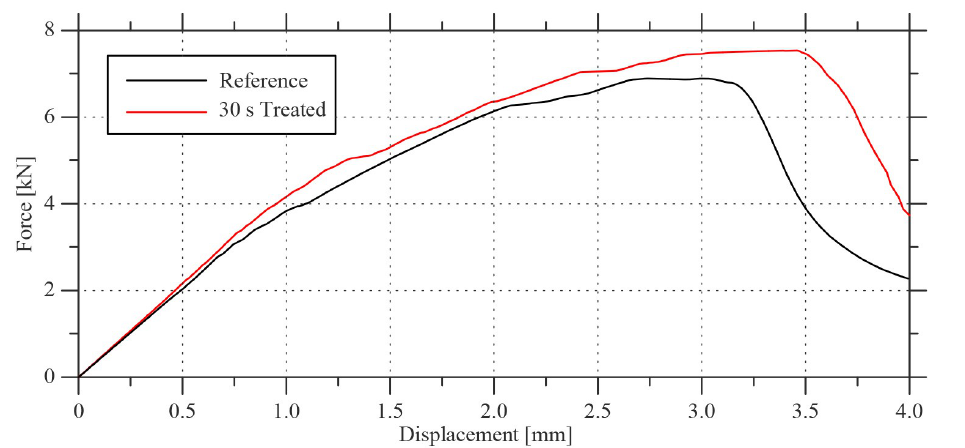
Figure 5. Force-displacement diagram of cement samples containing micro-fibers.